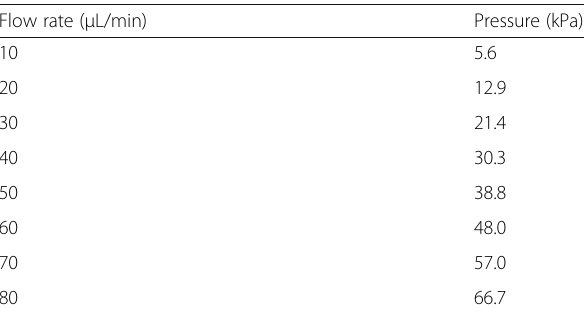
Table 2 Relationship between the flow rate and the